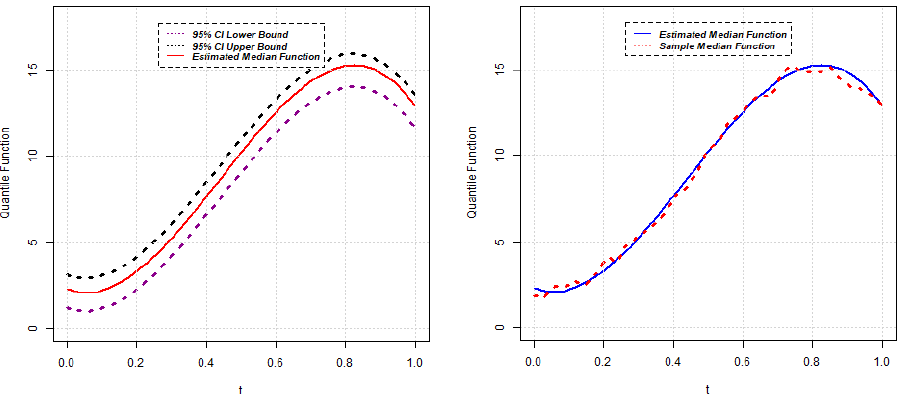
Figure 9. Estimated median function and C.I. ( left ); Estimated median and sample median ( right ) for Model 4.